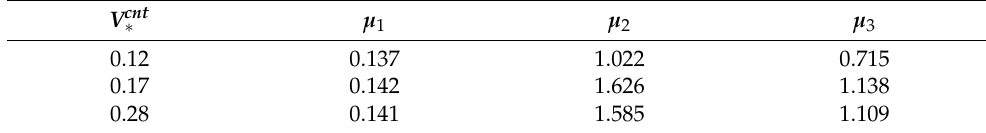
Table 3. Volume fractions and efficiency parameters of the